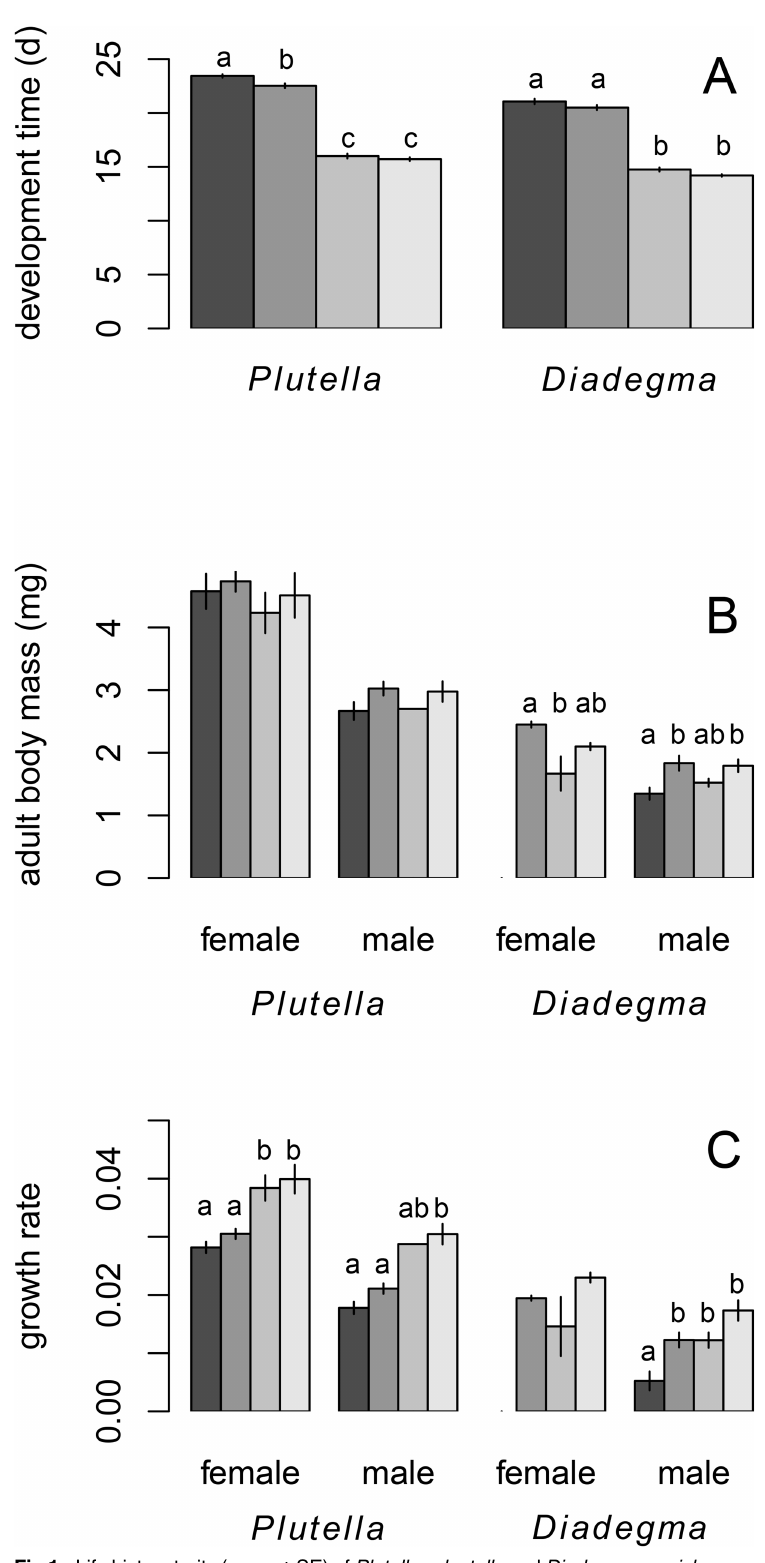
Fig 1. Life history traits (mean ± SE) of Plutellaxylostella and Diadegmasemiclausum exposedto different thermal regimes in experiment 1: A) development time, B) adult body mass, and C) growth rate. In B) and C)